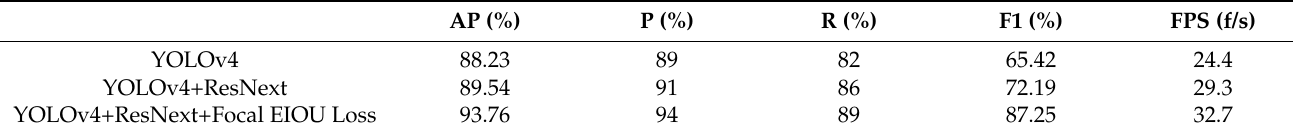
Table 1. Performance comparison of three